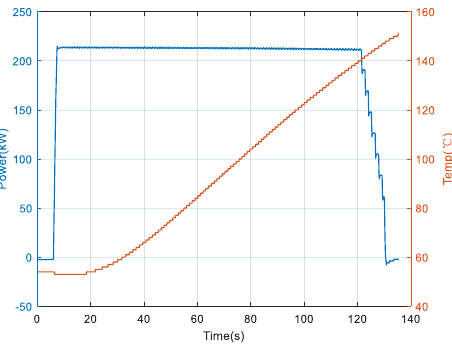
Figure 10. Curves of the output power and the motor temperature with time.